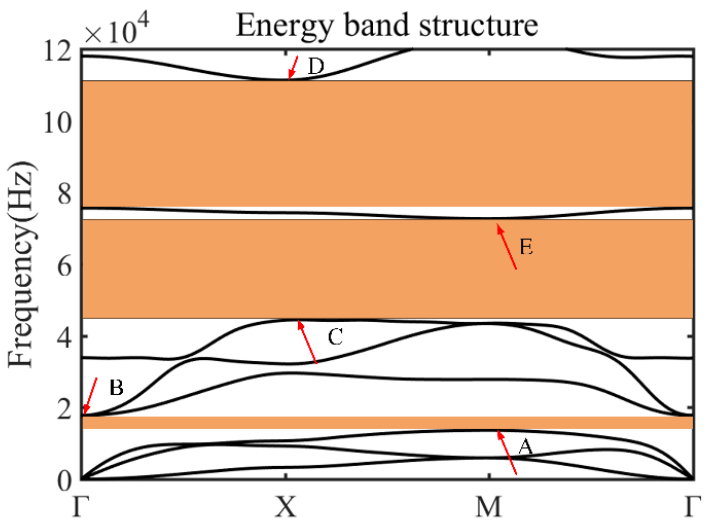
Figure 2. The schematic diagram of energy band structure for the designed unit cell. The parameters used are as follows: a = 7 mm, h 1 = 1.5 mm, h 2 = 3 mm, b 1 = 3 mm, L 1 = 2.6 mm, L 2 = 2 mm, b 2 = 0.6 mm.